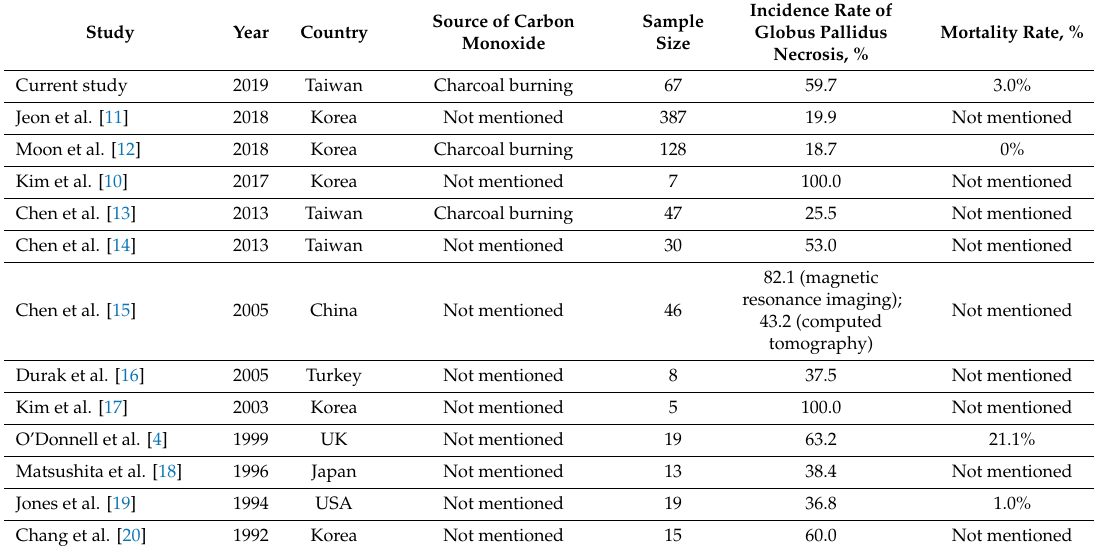
Table 4. Comparison of outcomes between current and published studies (sample size ≥ 5) from di ff erent geographic